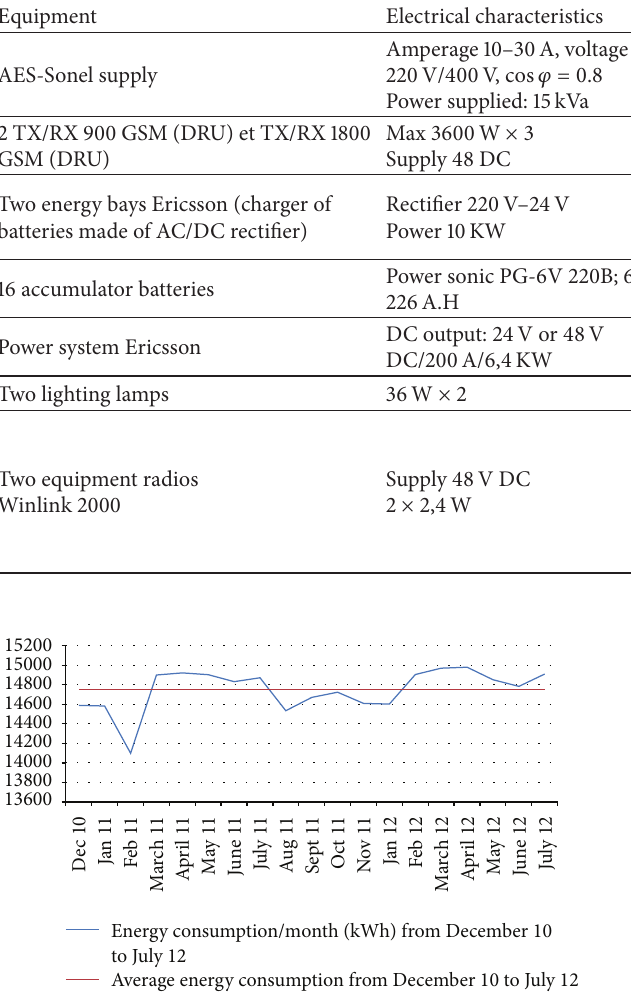
Figure 3: Monthly energy consumption curve, CRTV site from December 10 to July 12.